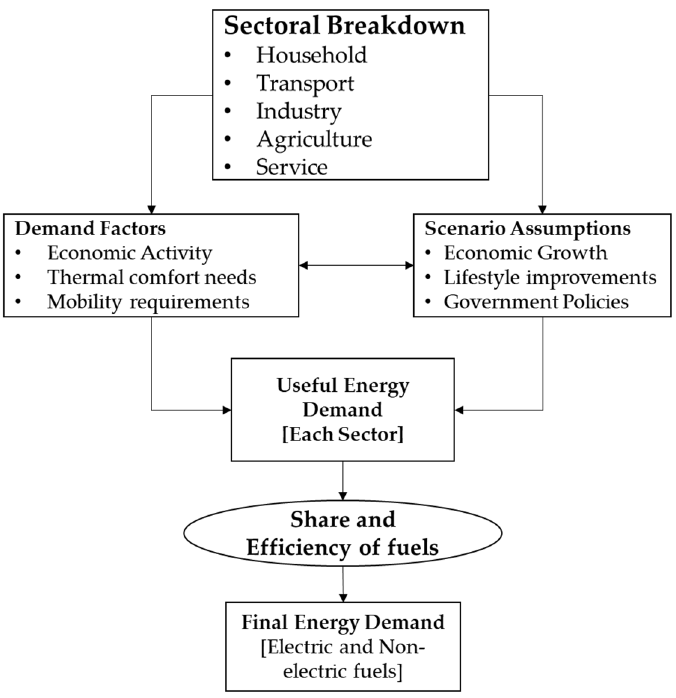
Figure 4. The framework of the bottom-up energy demand model. Activity and energy intensity of any sector/sub-sector are the main factors for energy demand simulation. Table 3 shows the definition of activity for different sectors and sub- sectors. The total amount of energy consumption can be estimated from the multiplication of energy intensity to the unit of activity for each Table 3. Definition of the terms of activity in the bottom-up energy demand.